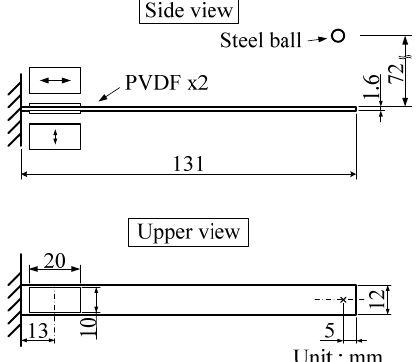
Figure 2. Setup of the first experiment for investigation of the